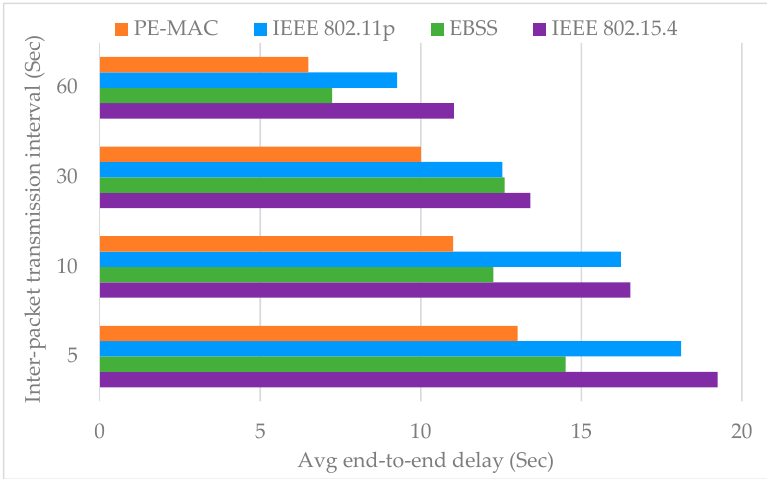
Figure 13. Impact of inter packet transmission interval on average end-to-end delay: for proposed PE-MAC, EBSS, standard IEEE 802.15.4 and IEEE 802.11p.